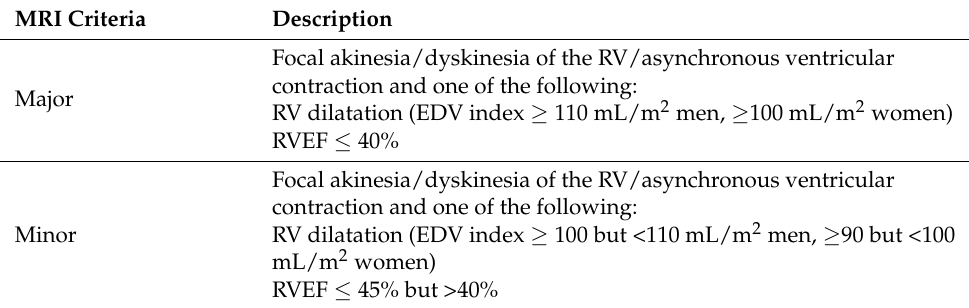
Table 2. The revised Task Force Criteria 2010 for